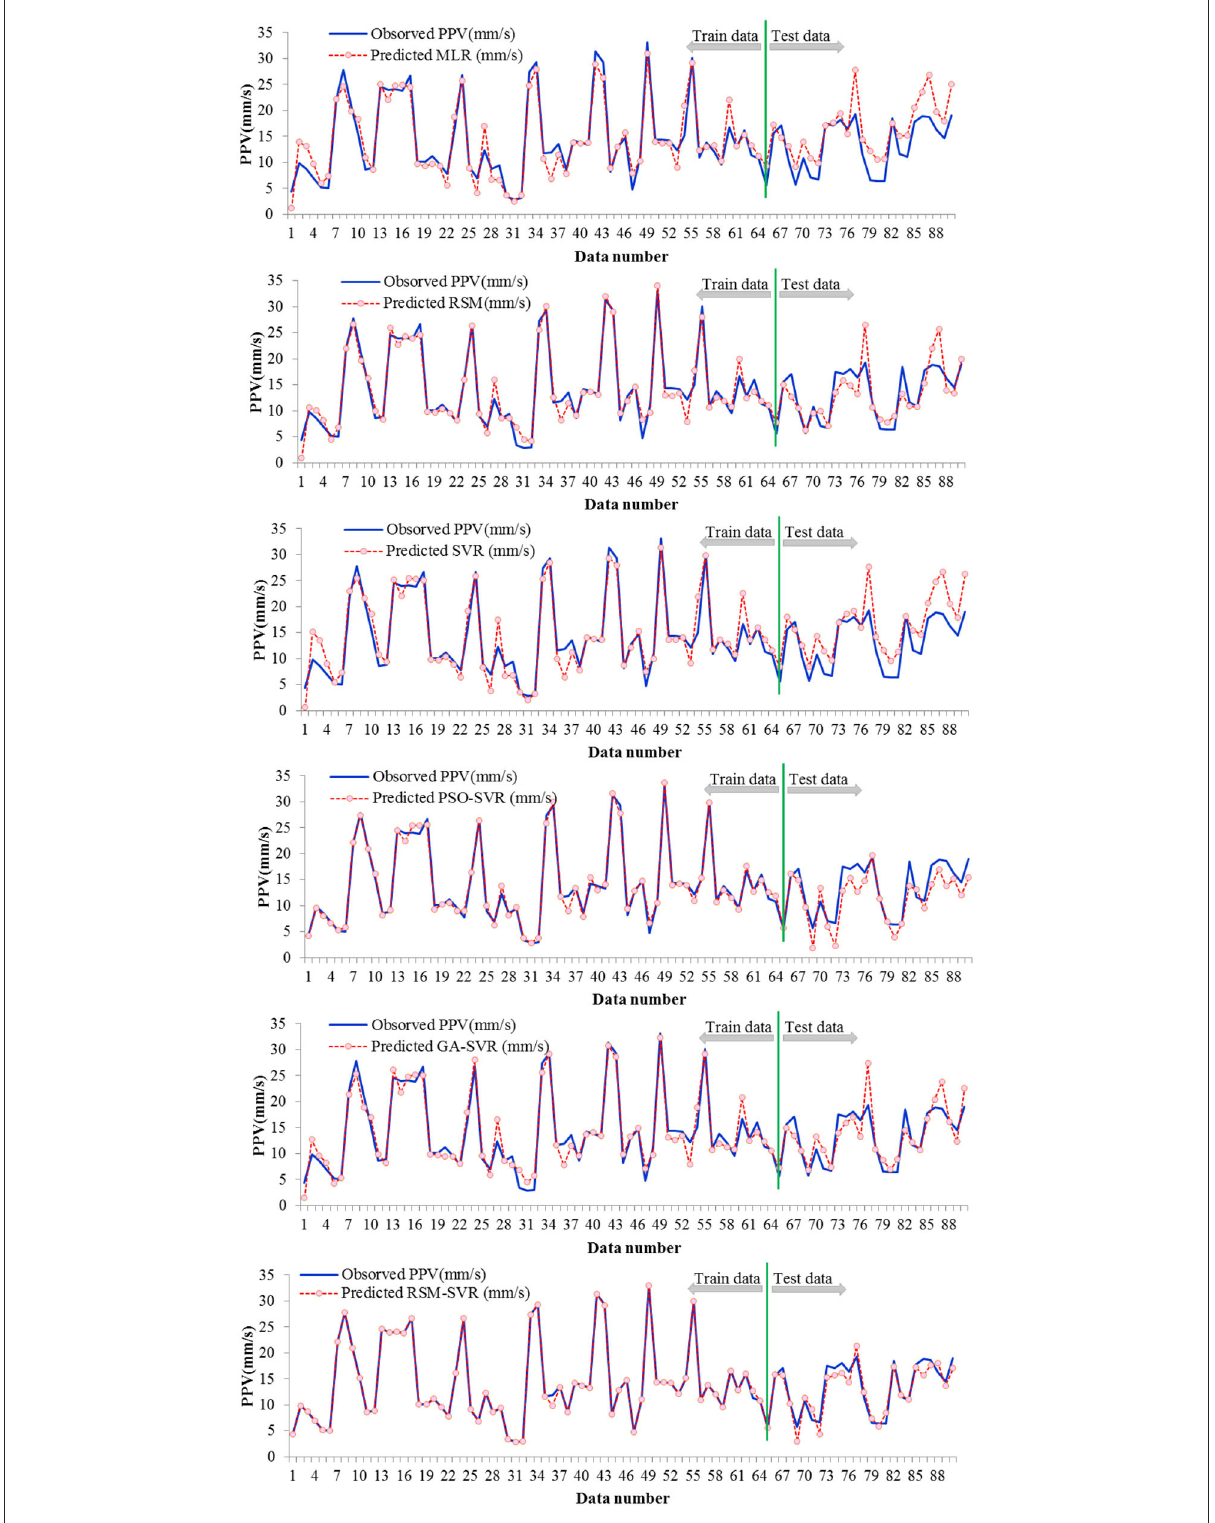
FIGURE3 Comparison of predicted and observed data points of PPV for the developed